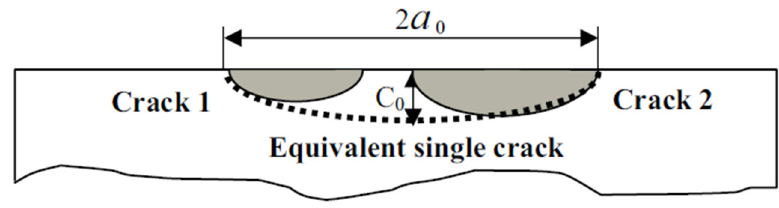
Figure 7. Simplified crack model to simulate multiple cracks site [40].